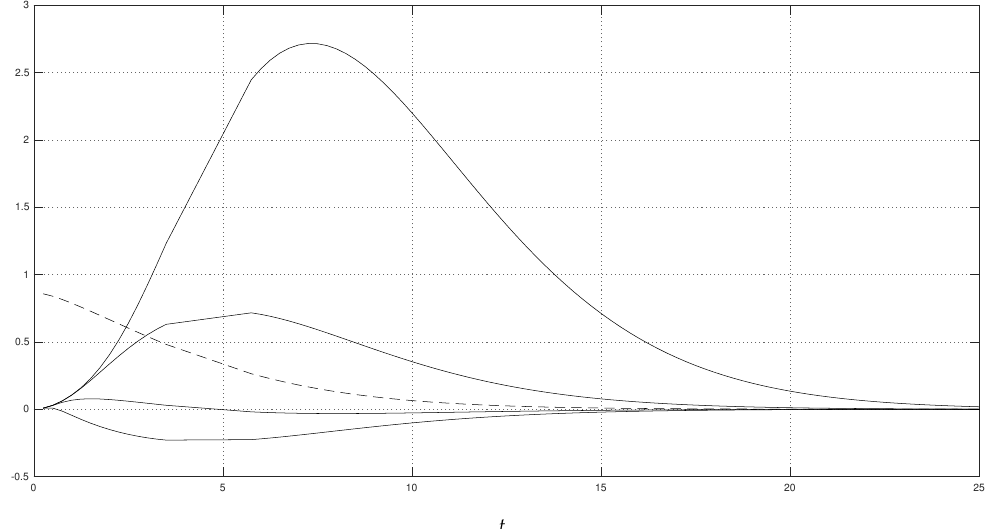
Figure 1. Poisson with λ = 2 compound sum of independent gamma with α = 2 and β = 3 random variables. Dashed curve: s.f. Continuous curve, from lowest to highest curve: approximate stabilities for perturbation points x = 1, 2, 5, 10,